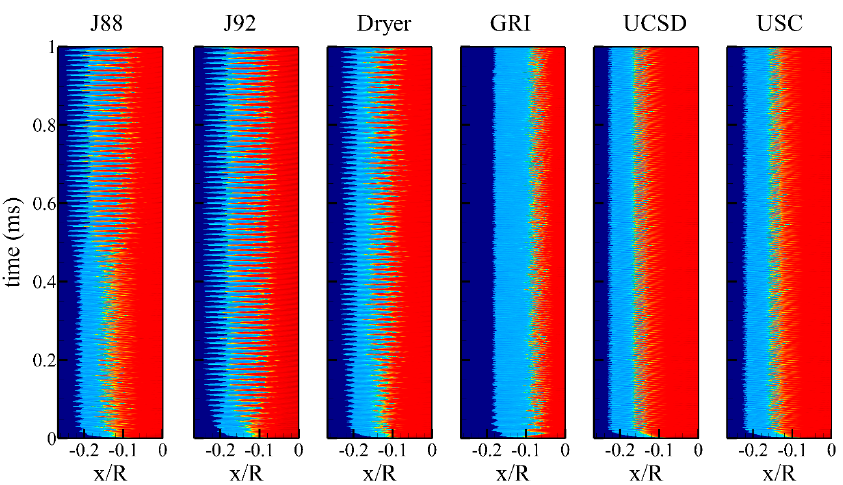
Figure 13. The x - t graph of SIC probed along the stagnation streamline for various reaction mecha- nism at 400 × 600 grid resolution. Color scale is the same as Figure 9.